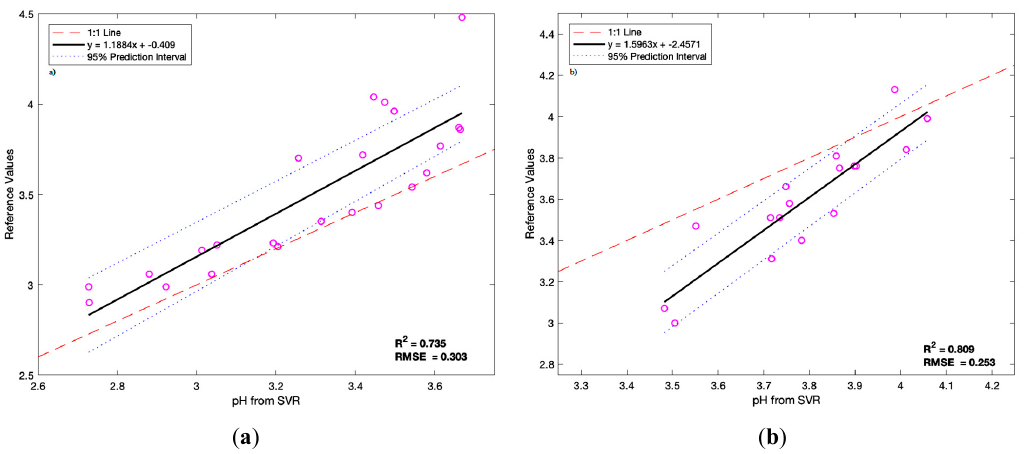
Figure 6. Results for the prediction of the pH index in the external test sets to further study the generalization capacity; ( a ) TB 2013 samples; ( b ) TN 2013 samples.